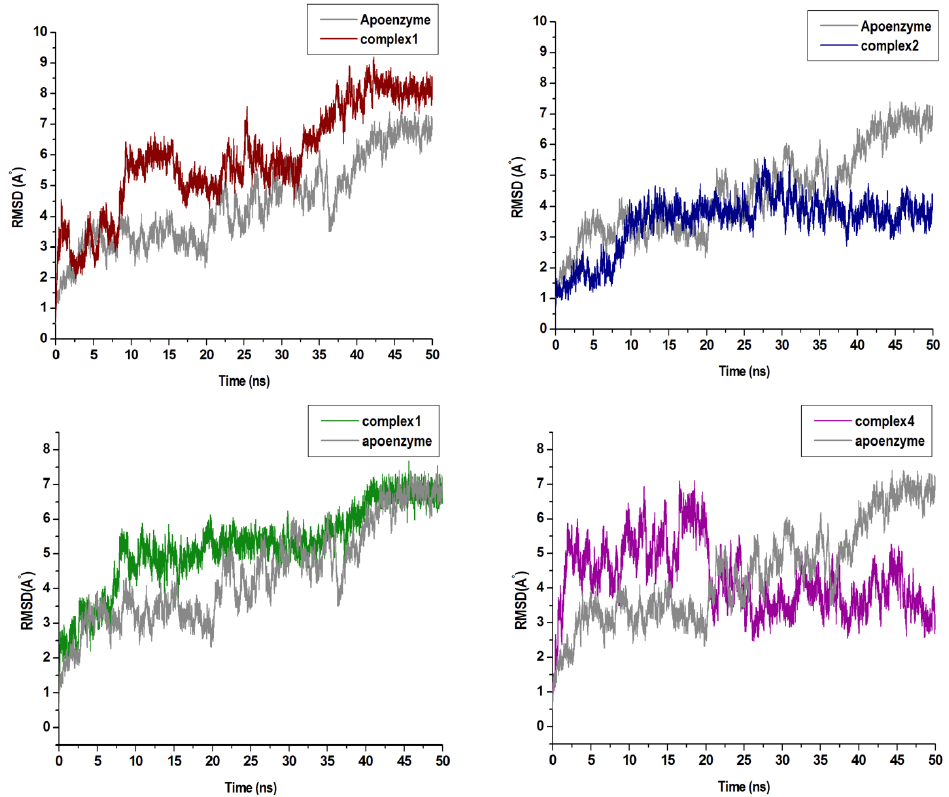
Figure 4. C-a backbone RMSD (Root-Mean-Square Deviation) plots of the four compounds in complex with Nedd4-1 when compared with the Apo enzyme.